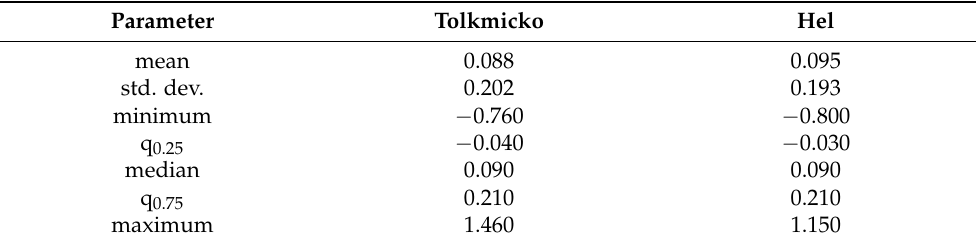
Table 1. Basic statistical characteristics of the WSE (m a.s.l.) at Tolkmicko and Hel stations (raw data).